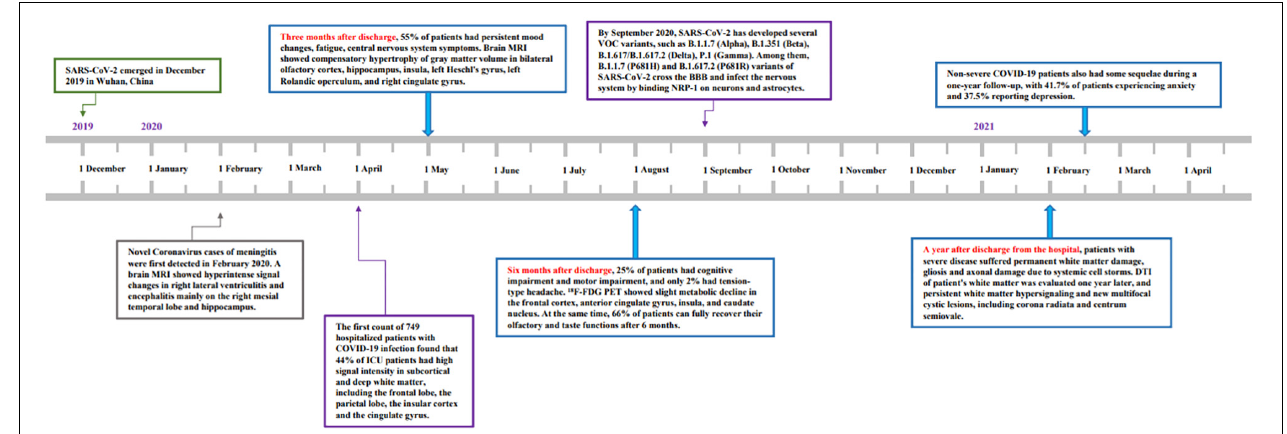
FIGURE 1 | Graph’s x-axis (dates from December 2019 to December 2021) shows the clinical timeline and dynamics of microstructural changes in Coronavirus Disease-19 (COVID-19) encephalopathy in China. Novel Coronavirus cases of meningitis were first detected in February 2020. By September 2020, severe acute respiratory syndrome coronavirus-2 (SARS-CoV-2) had developed several variants of concern (VOC), such as B.1.1.7 (Alpha), B.1.351 (Beta), B.1.617/B.1.617.2 (Delta), and P.1 (Gamma). Three months after discharge, 55% of patients had persistent mood changes, fatigue, central nervous system symptoms. Six months after discharge, 25% of patients had cognitive impairment and motor impairment, and only 2% had tension-type headache. At the same time, 66% of patients fully recovered their olfactory and taste functions after 6 months. A year after discharge from the hospital, 2,433 patients who were discharged from Wuhan hospital were followed up and observed. It was reported that severe patients still had fatigue, sweating, anxiety, and joint pain after